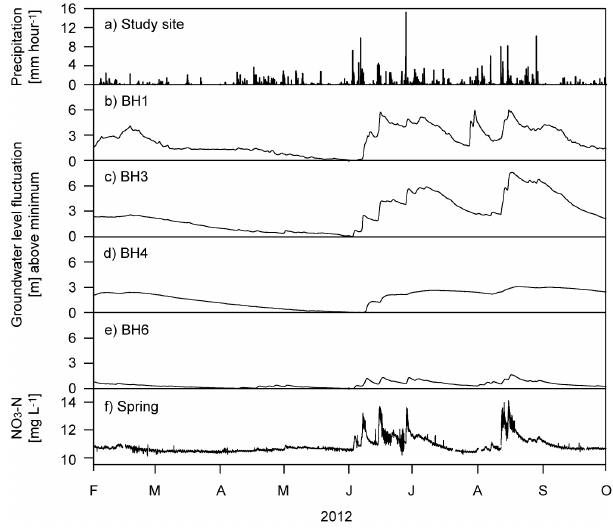
Figure 3. Observations at the study site in period (2) between 1 February and 1 October 2012: (a) precipitation; (b–e) groundwater fluctuation at BH1, BH3, BH4 and BH6 in metres above minimum; (f) NO 3 -N pattern at the